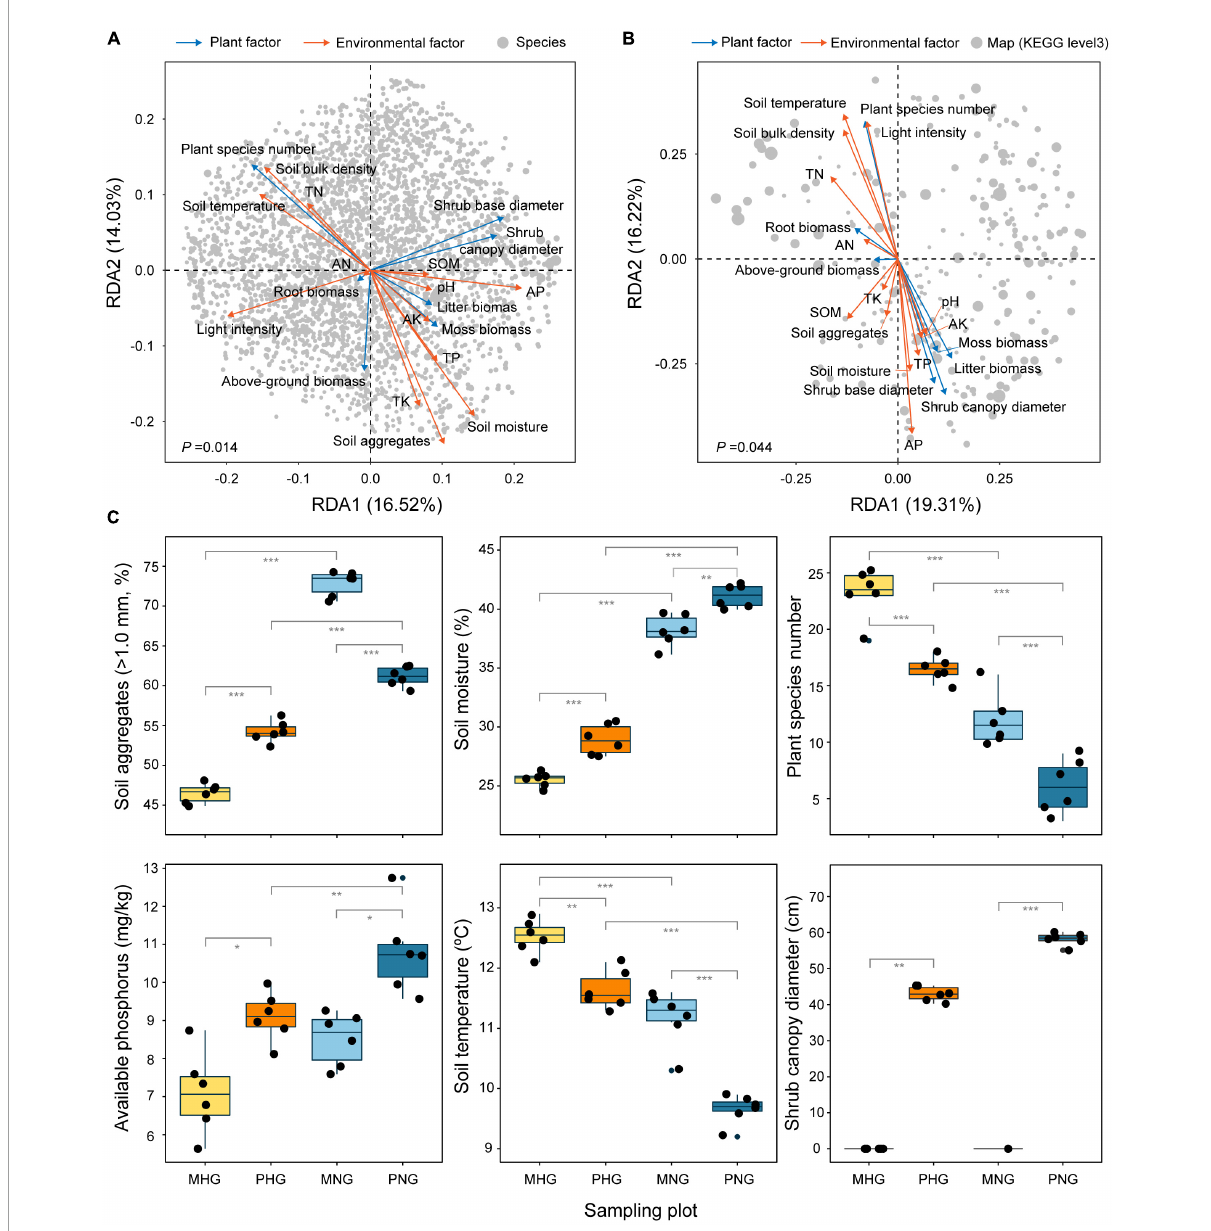
FIGURE6 Plant and environmental factors predicted to affect microbial composition and function. Extent of interpretation of (A) species distribution and (B) function performance by influencing factors. Gray dots indicate microbial species in (A) and maps (KEGG level 3) in (B) . The dot size indicates the relative abundance of species/functional genes. The cyan arrows indicate the plant factors and the orange arrows indicate the environmental factors in (A,B) . AK, available potassium; AN available nitrogen; AP, available phosphorus; SOM, soil organic matter; TK, total potassium; TN, total nitrogen; TP, total phosphorus. (C) According to the results in (A,B) , relatively important factors were analyzed, including soil aggregates, soil moisture, species number, AP, soil temperature, and shrub canopy diameter. The number of asterisks indicates the level